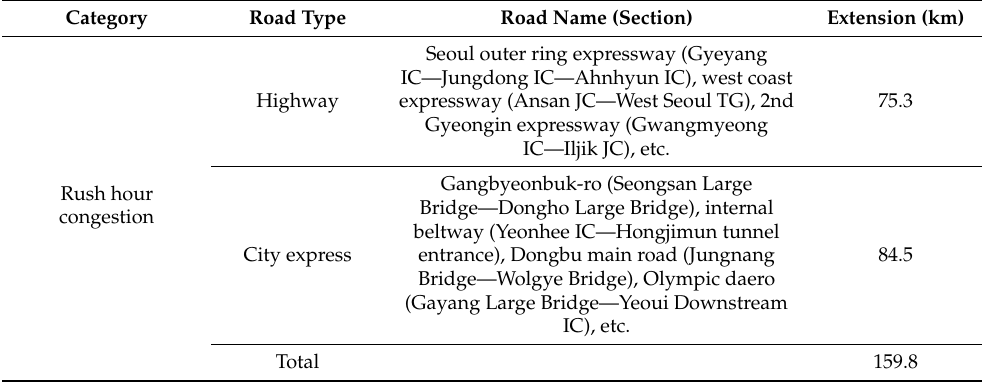
Table 1. Major congestion